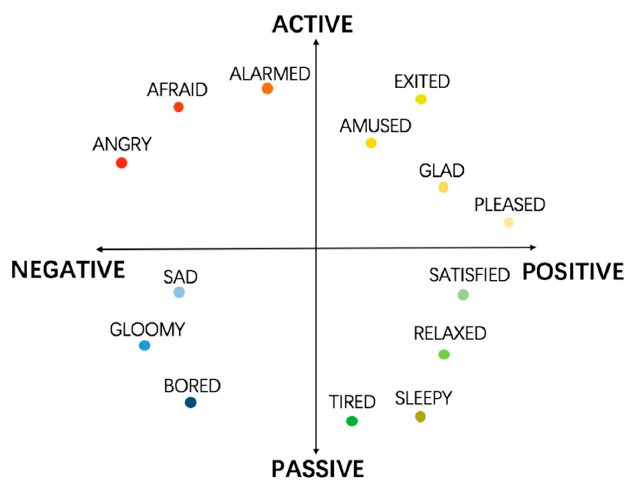
Figure 2. 2D emotion space model.